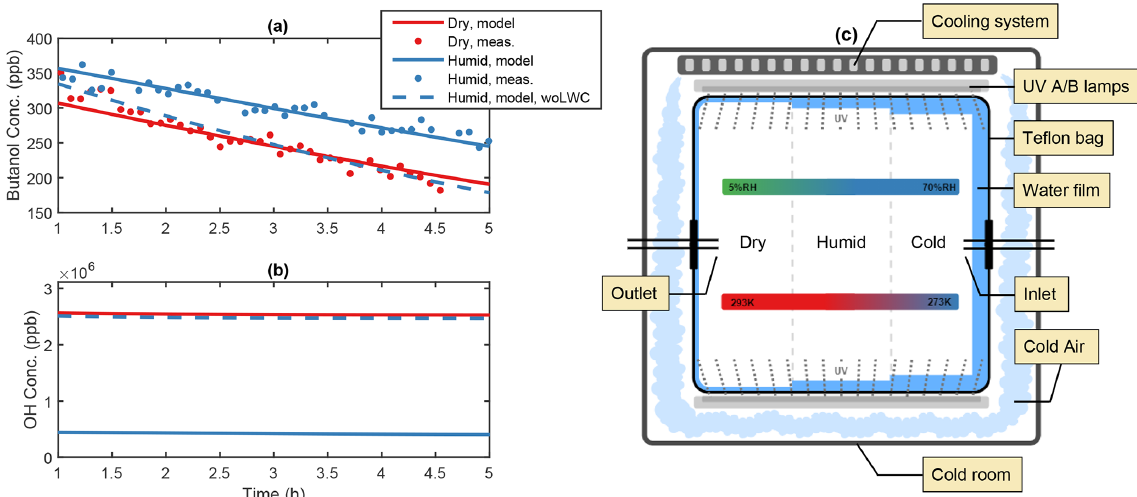
Figure 1. Illustration of the water film effect in the AURA chamber. Panel (a) depicts the PTR-MS butanol decay from experiments BUT1 (red) and BUT2 (blue) and (b) the OH concentration at varying RH with and without the influence of a liquid water film (woLWC: without liquid water content). The water content changed in accordance with varying temperature and RH (c) . Outside cooling of the chamber may affect the water adsorption on the Teflon